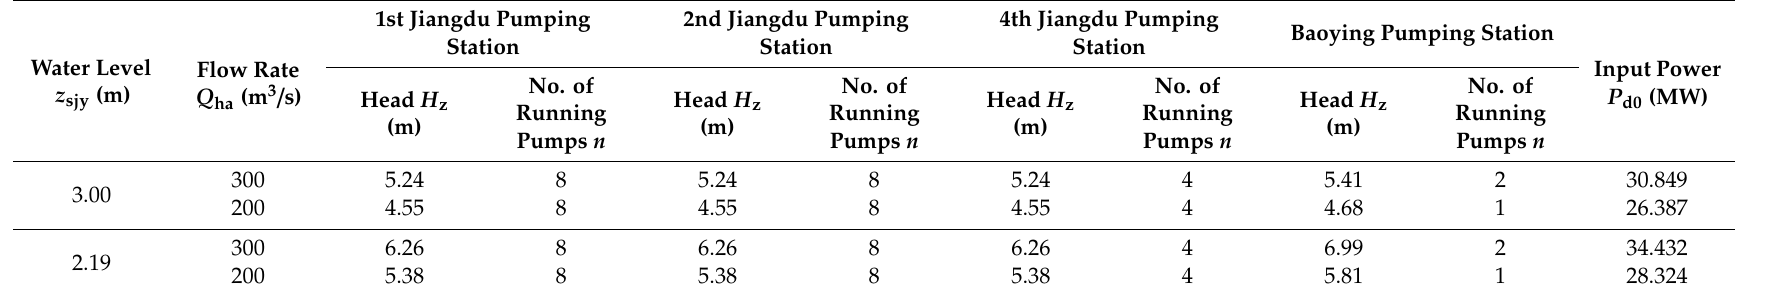
Table 8. Pump unit operation schemes with original discharge distribution ratio and fixed blade angles.